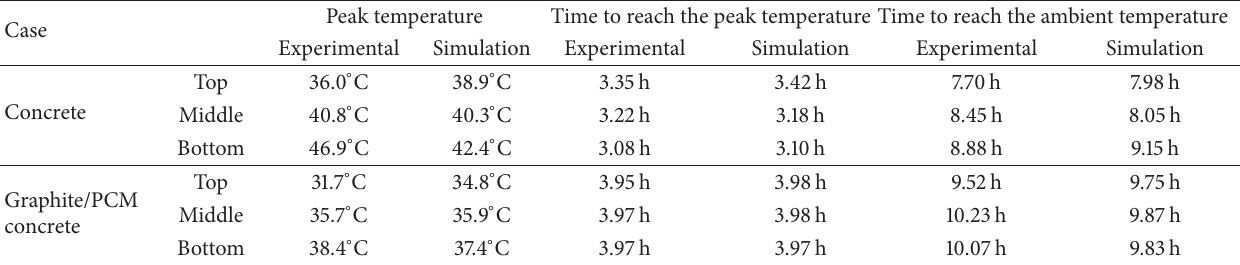
Table 3: Comparison of thermal behaviors between simulation and experimental values.